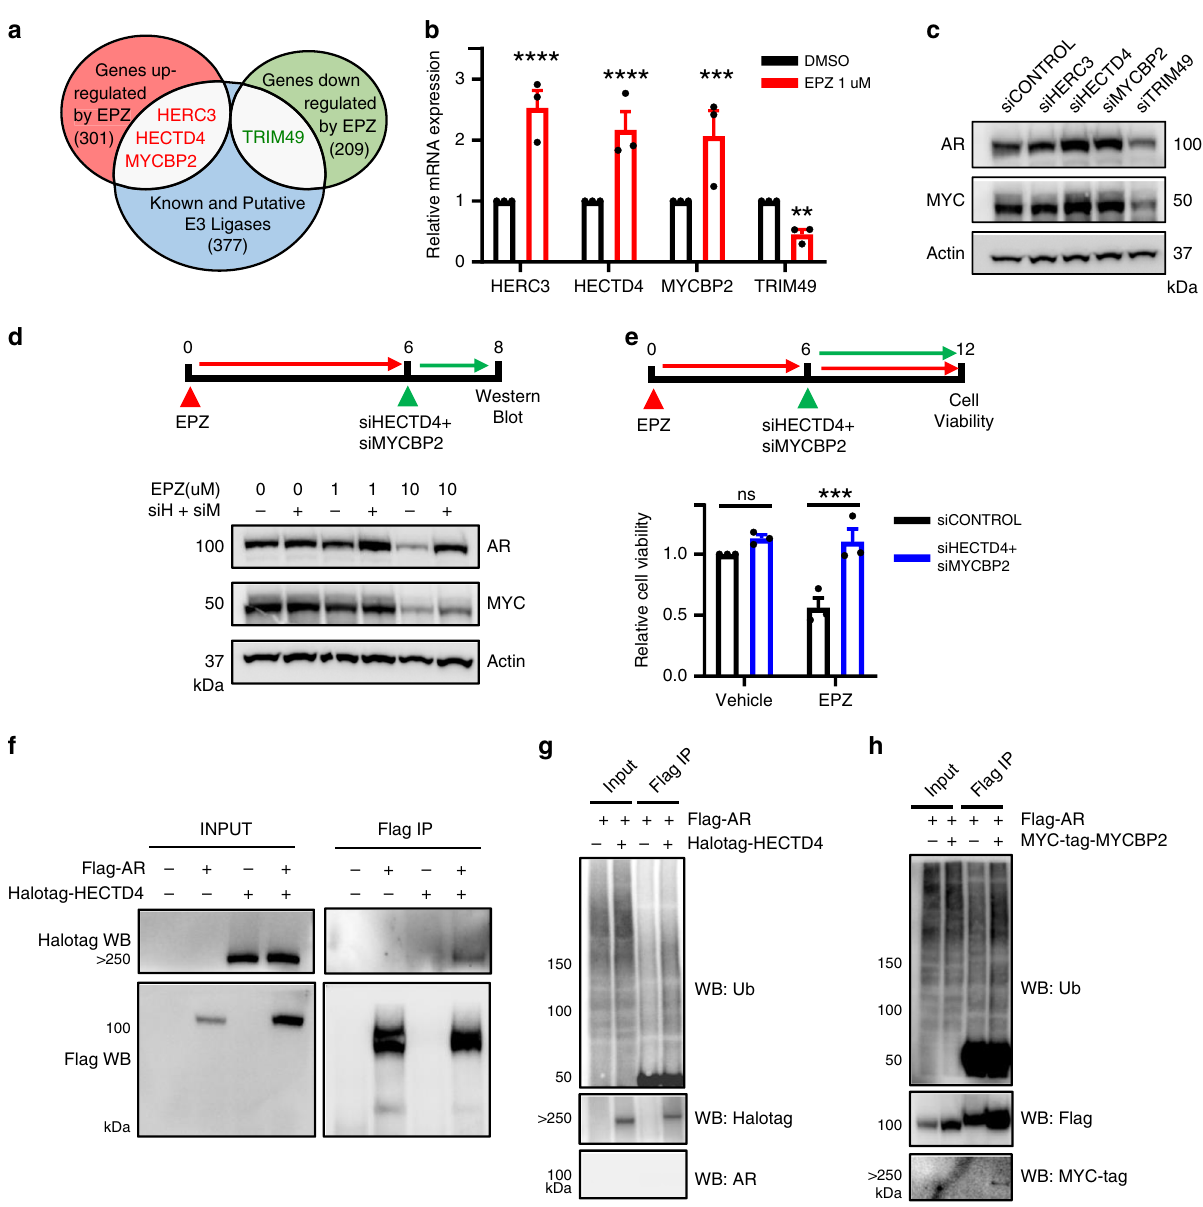
Fig. 5 EPZ-regulated E3 ligases target AR and MYC stability. a Comparison of genes that are differentially expressed by EPZ ( n = 510) and known E3 Ubiquitin ligases. b mRNA expression of HERC3, HECTD4, MYCBP2 , and TRIM49 in LNCaP treated with vehicle or 1 μ M EPZ for 8 days. c AR and MYC protein levels in LNCaP cells 2 days after being transfected by Control, HERC3, HECTD4, MYCBP2, and TRIM49 targeting siRNA. Representative images shown. d AR and MYC protein levels in LNCaP cells treated with Vehicle or EPZ for 6 days followed by transfection of Control or HECTD4 and MYCBP2 targeting siRNA for 2 days. Representative images shown. e Viability of LNCaP cells treated with Vehicle or EPZ for 6 days followed by transfection of Control or HECTD4 and MYCBP2 targeting siRNA measured by CCK8 assay at day 12. f Co-immunoprecipitation assays performed with Flag-AR pulldown followed by western blot analysis in 293T cells transfected with Flag-AR and Halotag-HECTD4 constructs after 2 days. g Flag-AR pulldown followed by Ubiquitin western analysis in 293T cells transfected with both Flag-AR and HECTD4 constructs. h Co-immunoprecipitation assays performed with Flag-AR pulldown followed by western blot analysis in 293T cells transfected with Flag-AR and MYC-tag-MYCBP2 constructs after 2 days. Statistical tests: p value determined by Student ’ s t test ( b , e ). Error bars represent S.E.M. n = 3 independent experiments ( b – e ), n = 2 independent experiments ( g , h ). ** p <